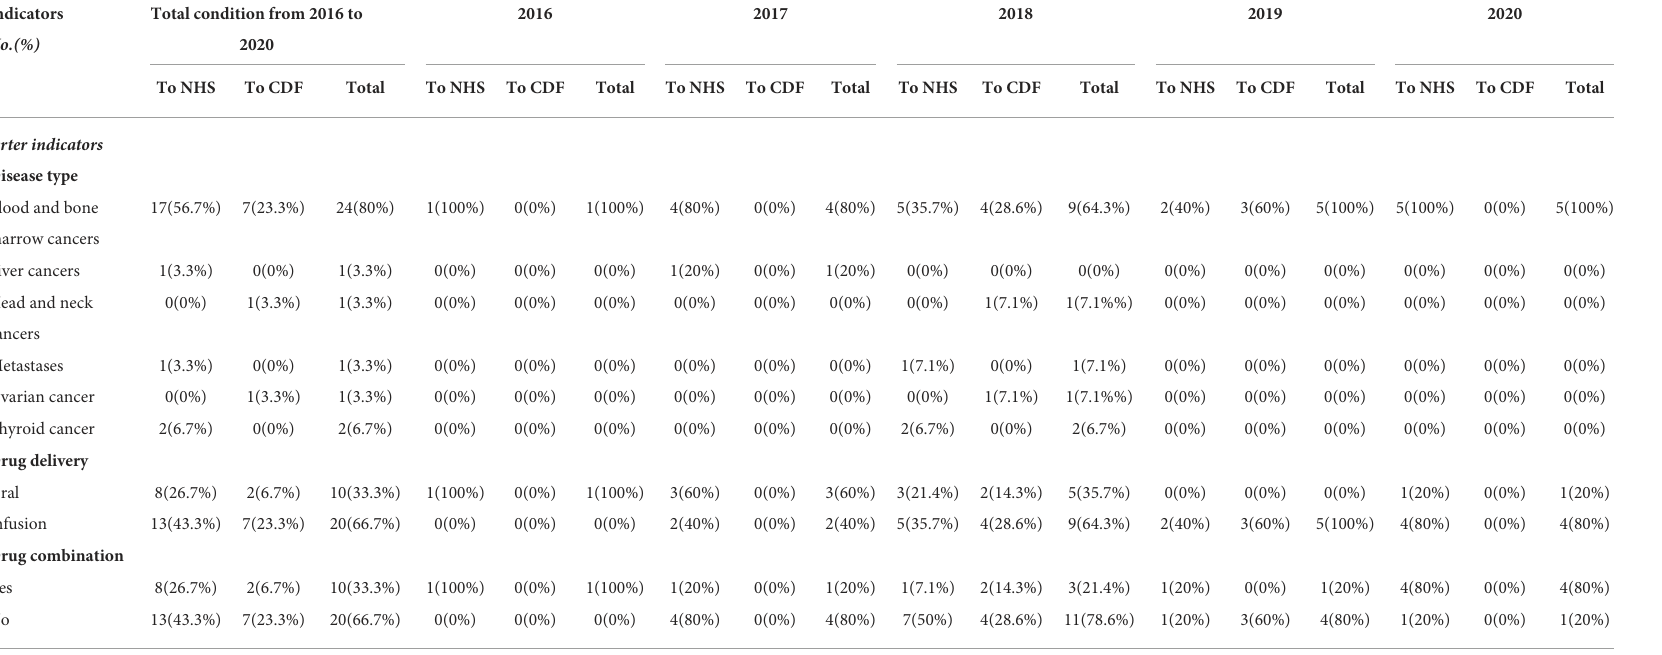
TABLE 5 Details of indicators of effectiveness in guidance from 2016 to